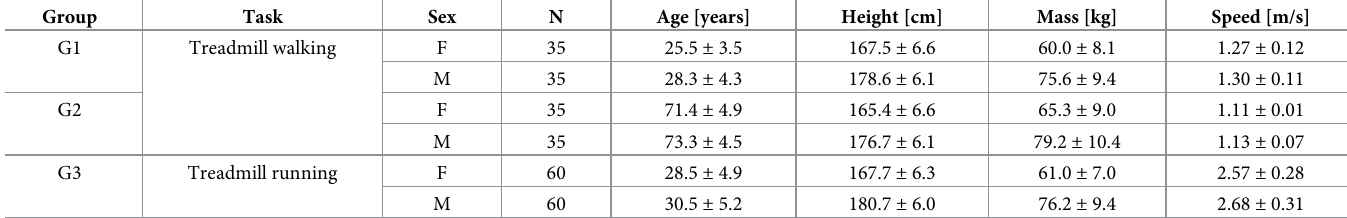
Table 1. Participant data and group division. Values are presented as mean ± standard deviation.